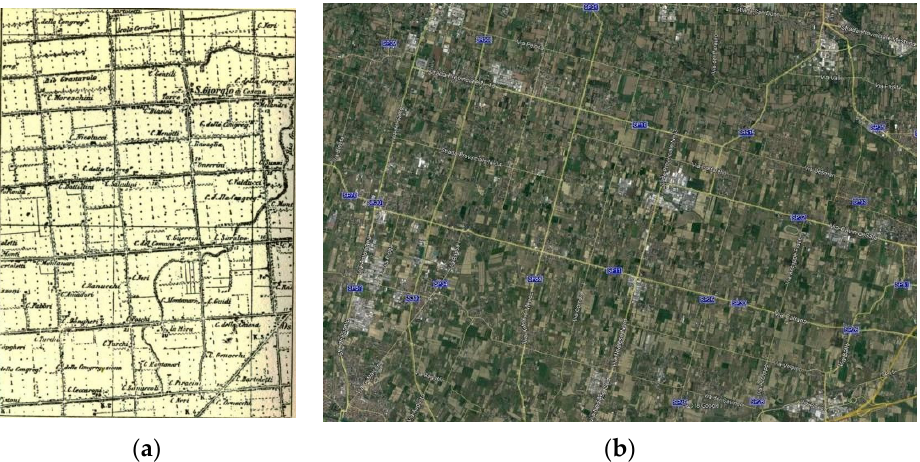
Figure 3. Centuriation near Cesena, Italy, in a late nineteenth century Italian military map—Roman grid system ( a ) and what is left today in the Po River valley with superimposition of the old system ( b ). Source: Wikipedia (https://en.wikipedia.org/wiki/Centuriation(accessed on 13 October 2021)).